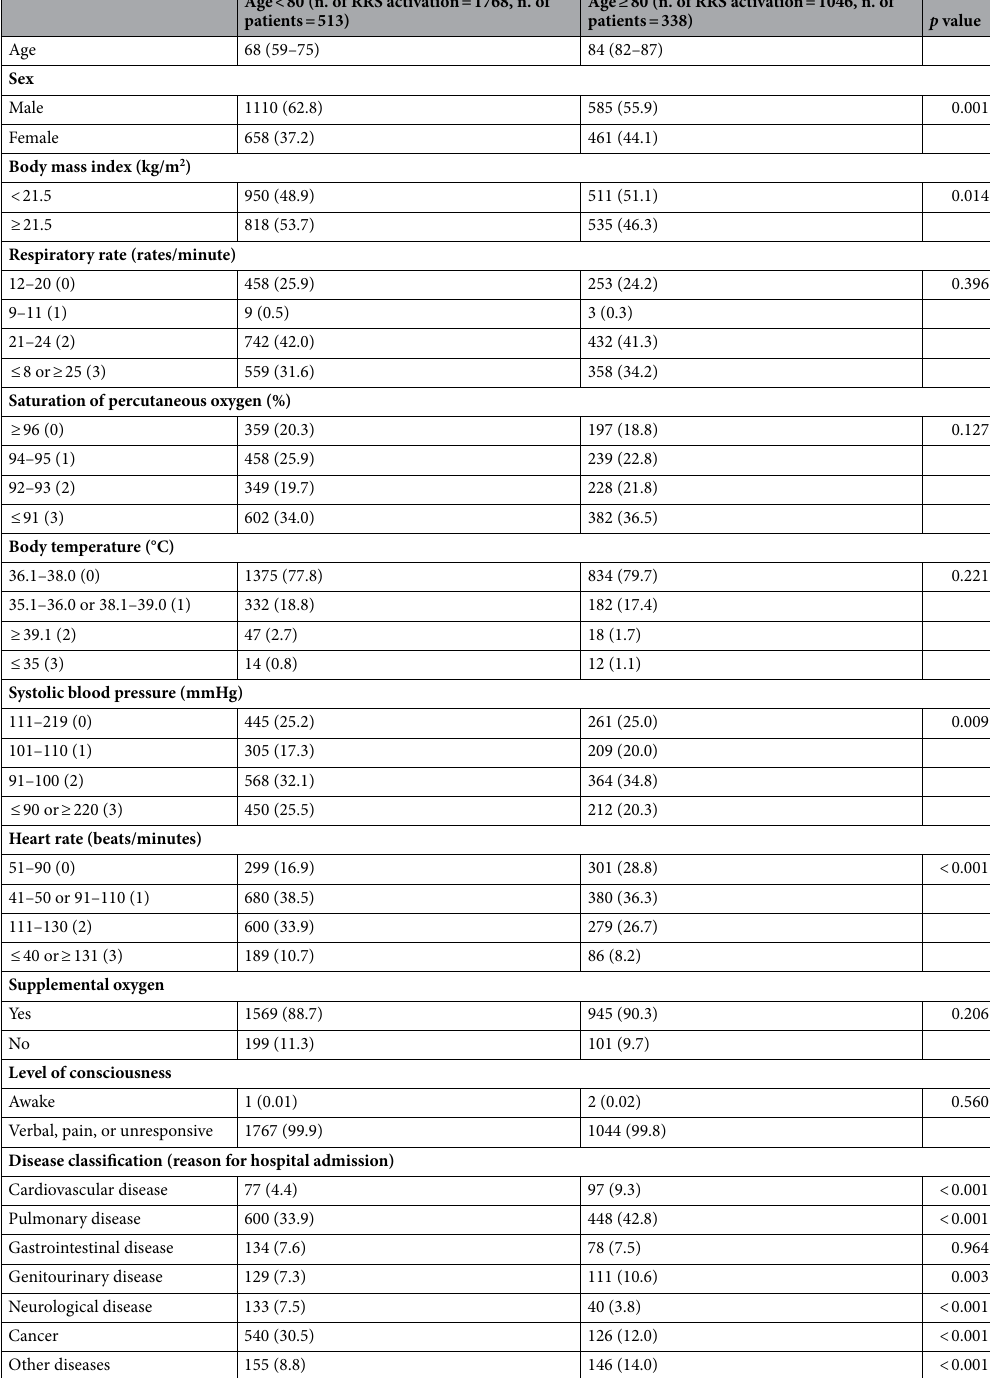
Table 1. Baseline characteristics of the study population by age group. Data are expressed as numbers (percentages) except age. Age is expressed as median and interquartile